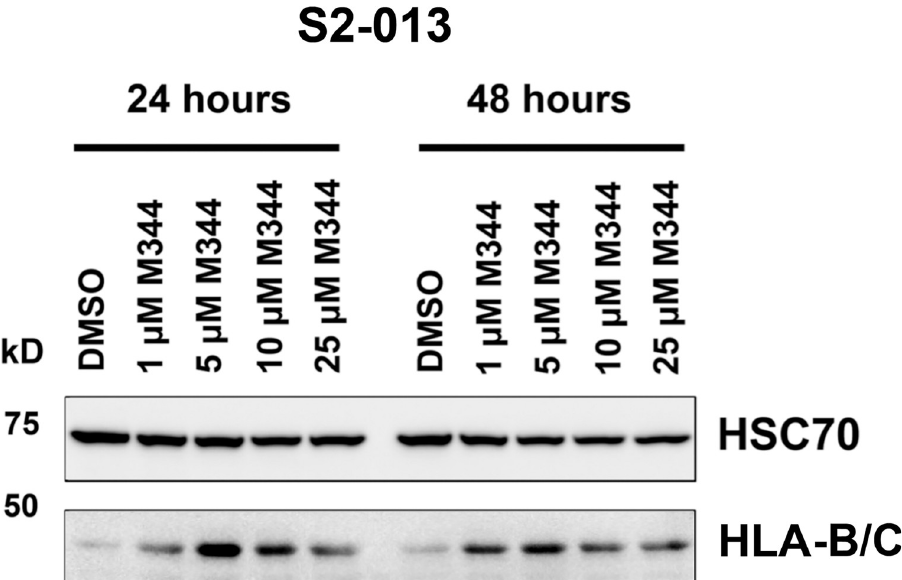
Fig 9. M344 treatment increases the expression of the human MHC class I heavy chains HLA-B and -C. For immunoblot analysis, lysates of S2-013 pancreatic cancer cells treated for 24 or 48 hours with 0.1% DMSO (vehicle control) or with 1, 5, 10, or 25 μ M M344 were subjected to electrophoresis, and the proteins were transferred to a membrane that was cut and one section was probed with an antibody for HSC70 (as a loading control) and another section was probed with an antibody to detect the MHC class I heavy chain (specifically, with the HC10 antibody that binds to HLA-B and HLA-C heavy chains). The exposure for the HLA-B/C heavy chains that is shown in the figure is longer than the exposure for the HSC70 control. Similar results were also obtained using the same M344 concentrations, time points, and antibodies in a separate experiment using different S2-013